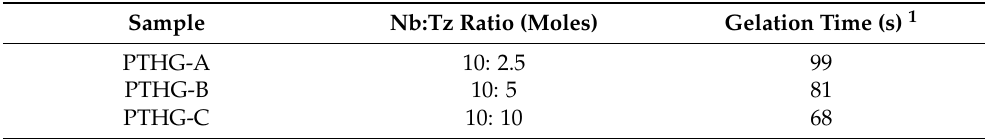
Table 1. Composition of hydrogels and their gelation